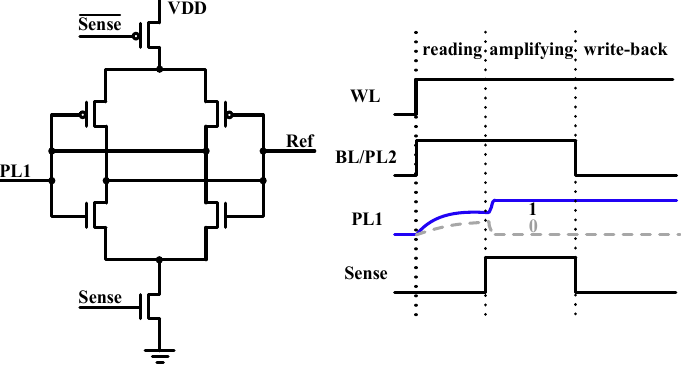
Figure 9. Schematic and timing of the latch SA.